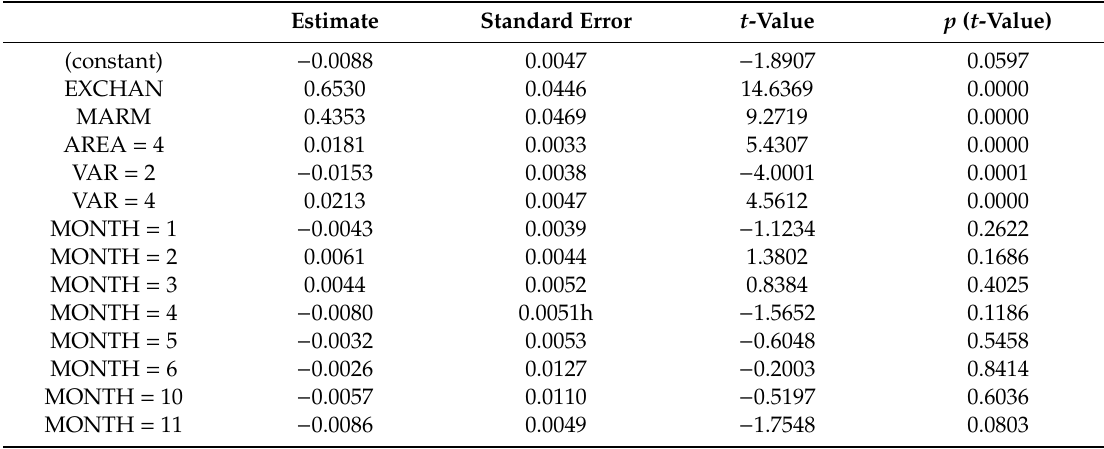
Table 3. Regression coe ffi cients for the model of the field prices of oranges (all variables).